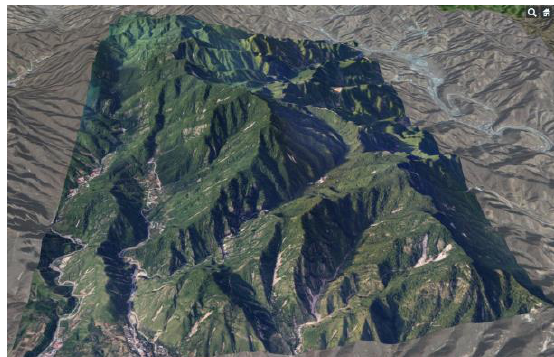
Figure 3. The research area shown in 3D The ASTER GDEM2 data of the research area was downloaded from the web as a GeoTIFF file. ASTER refers to WGS84, with the heights transformed via EGM96 to a physical height. The ASTER GDEM2 data of the research area is shown in Figure 4.